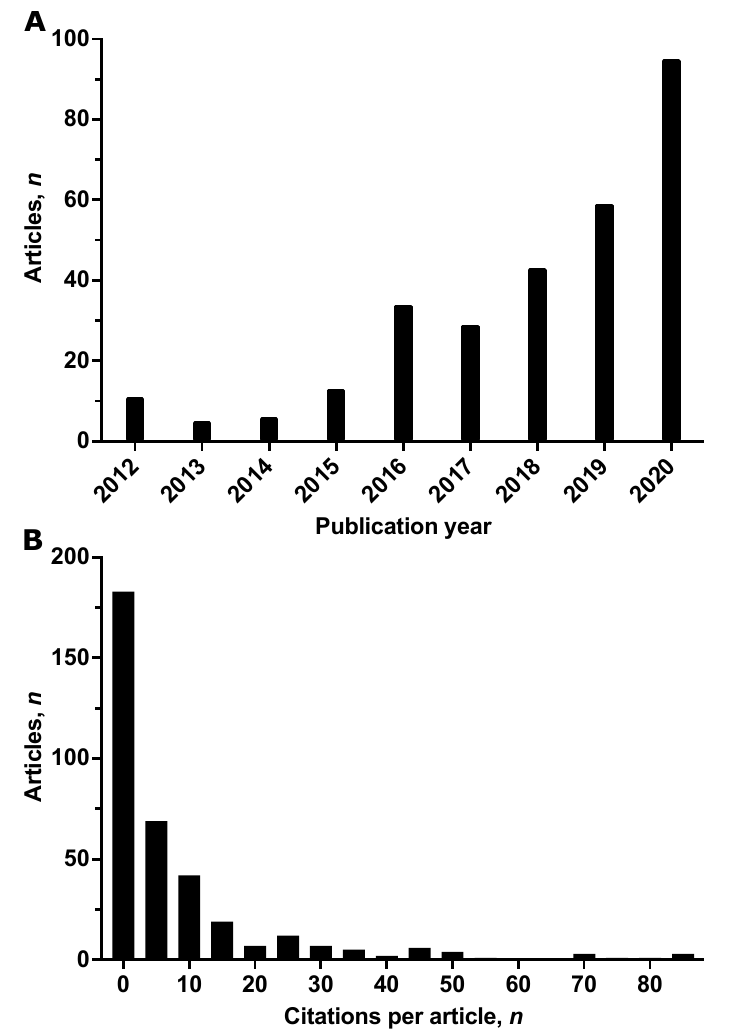
Figure 2. ( A ) Number of articles on post-intensive care syndrome, by year. Up to the Web of Science search on September 7, 2021, 78 articles were published in 2021. ( B ) Histogram of the number of citations per article (bin width of five citations). Eight articles with >100 citations (range: 125–939 citations) are not displayed.